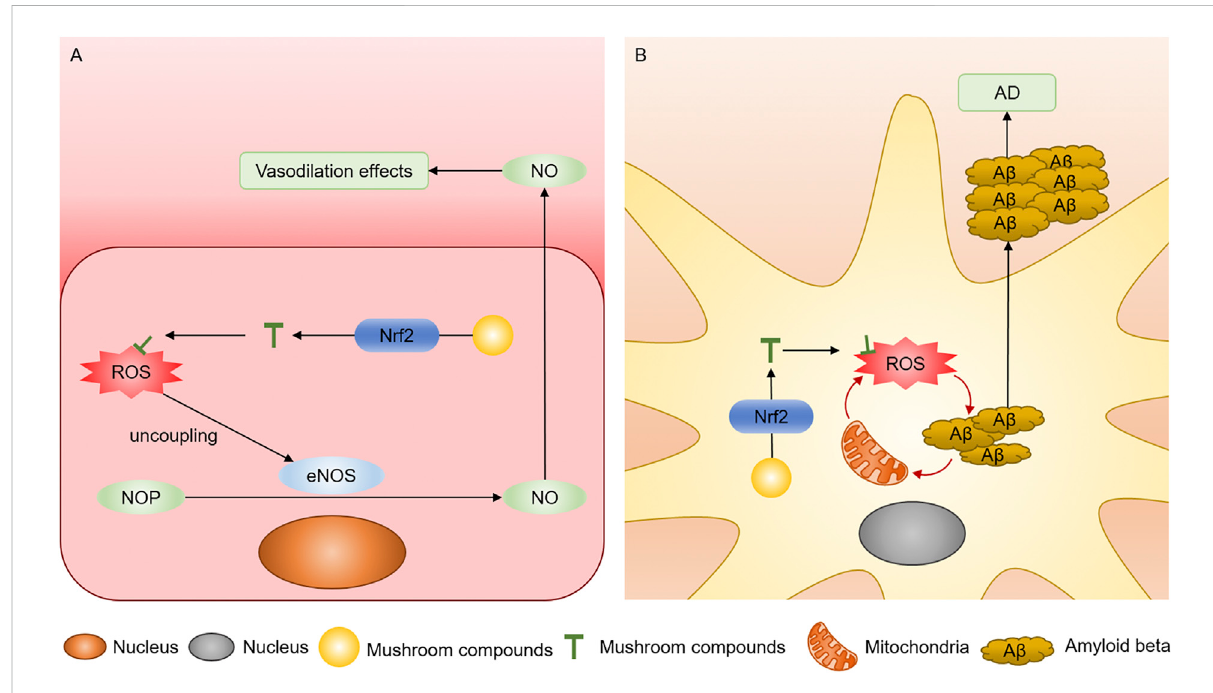
FIGURE 4 (A) Compounds in mushrooms inhibit eNOS uncoupling through the Nrf2 pathway. (B) Compounds in mushrooms neutralizeROS through the Nrf2 pathway and inhibit A β